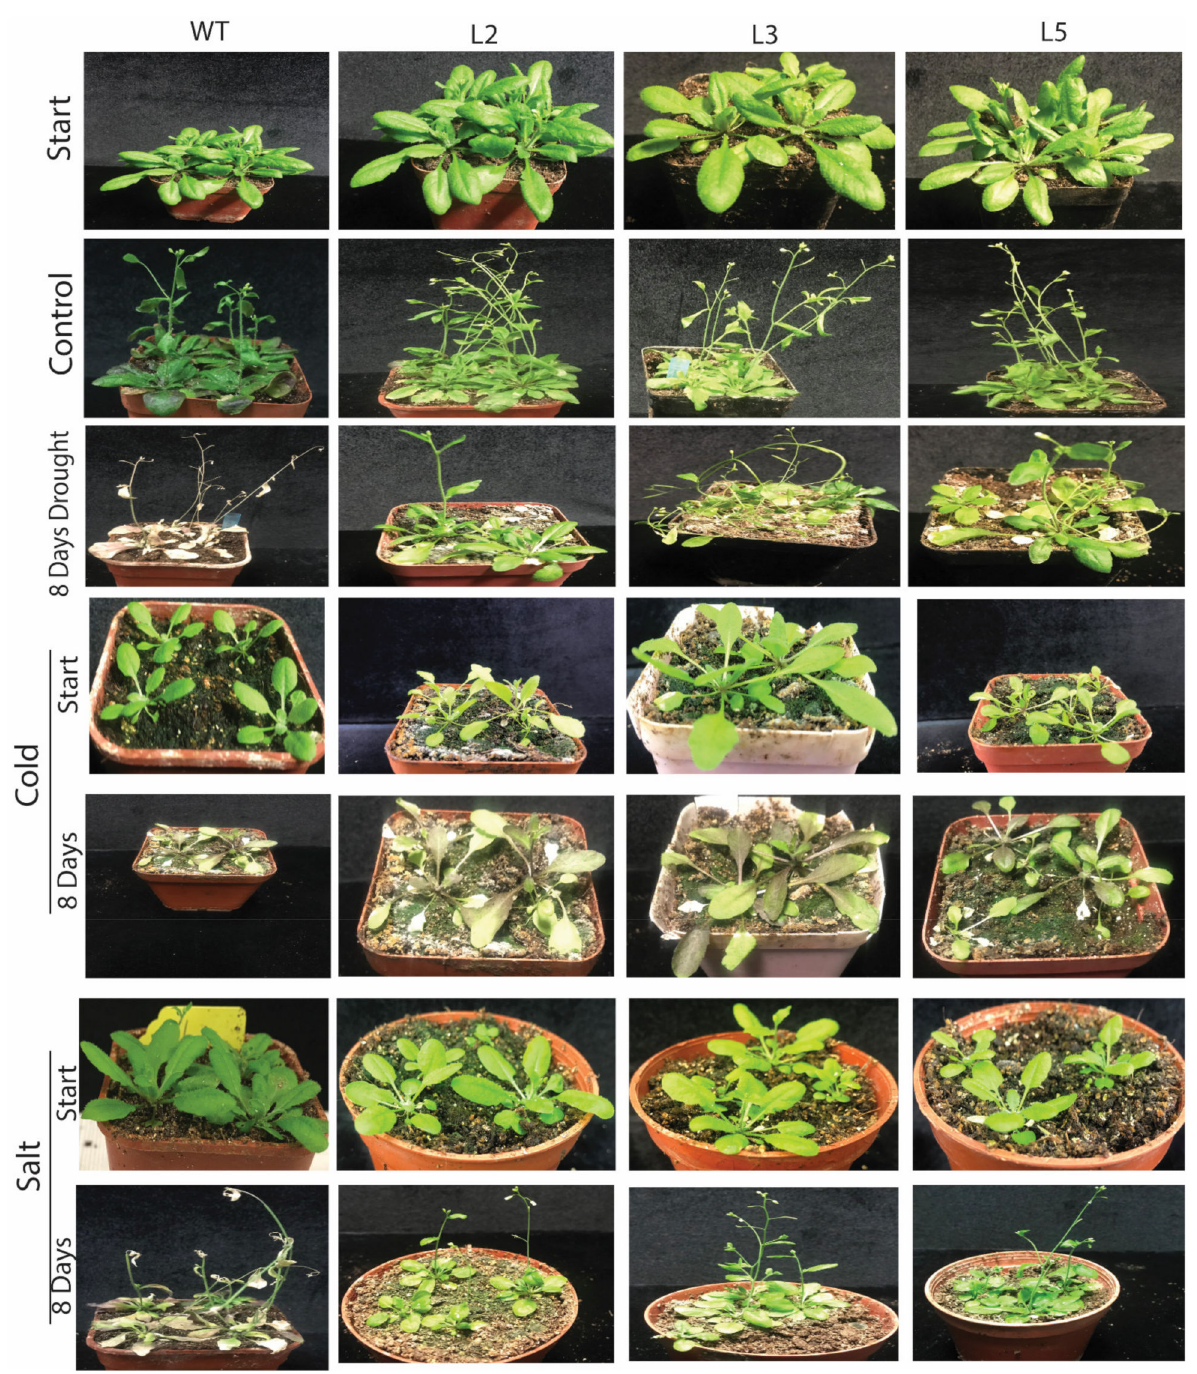
Figure 4. Physical features of GhMPK3 -transformed lines and WT plants prior and post-cold, drought, and salt